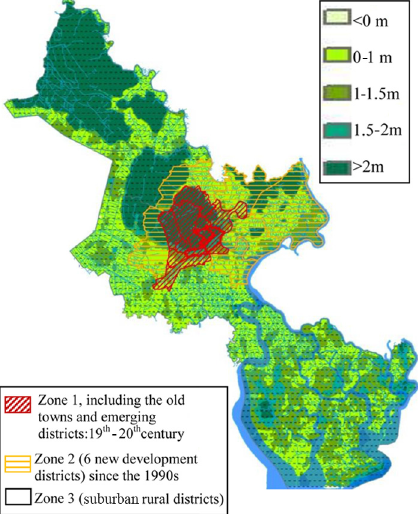
Figure 1. Urban zones layered over